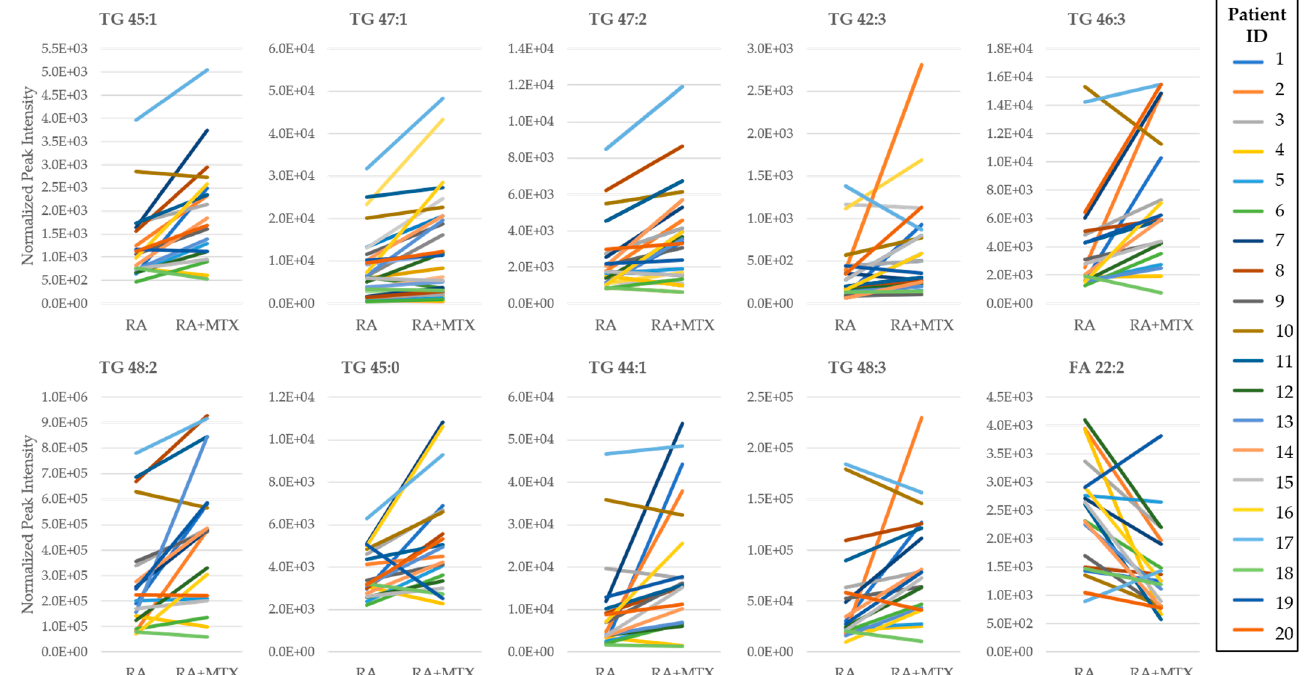
Figure 3. Pair-wise comparison of the top ten ranking metabolites identified from the volcano plot of the plasma metabolome of RA patients at baseline and following 16 weeks of MTX therapy. Rankings were based on p -value. Normalized peak intensities for each RA patient at baseline (RA) and following 16 weeks of MTX therapy (RA + MTX). Triglyceride (TG); fatty acid (FA).